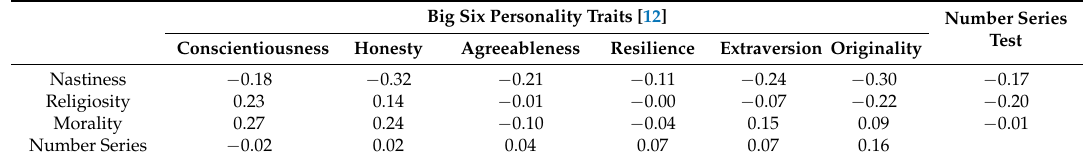
Table 1. Correlations between Social Attitudes, Personality and Number Series Test (N =